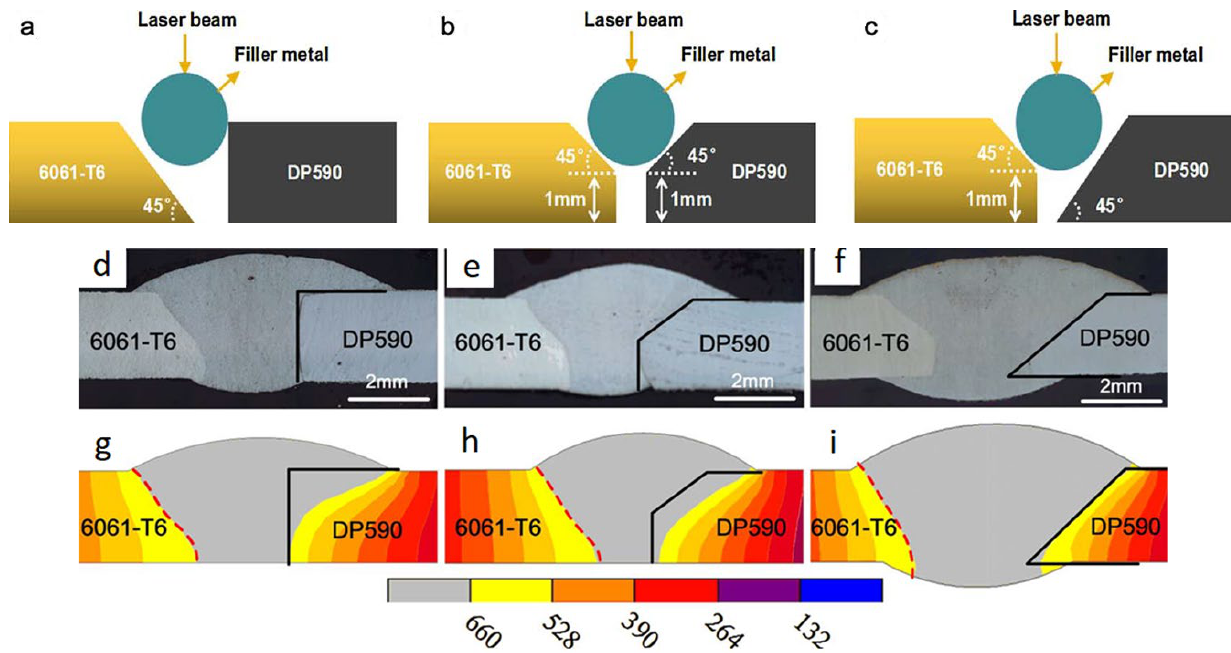
Figure 5. Diagram of weld cross section under different groove shapes: ( a ) square-shape groove at steel side, ( b ) half Y-shape groove at steel side, ( c ) half V-shape at steel side. Comparison of weld profile between experimental and numerical results: ( d ) experimental joint with square-shape groove, ( e ) experimental joint with half Y-shape groove, ( f ) experimental joint with half V-shape groove, ( g ) numerical joint with square shape groove, ( h ) numerical joint with half Y-shape groove, ( i ) numerical joint with half Y-shape groove [26].